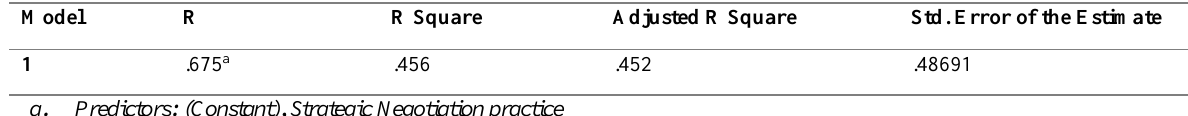
Table 2: Model Summary of Strategic Negotiation practice